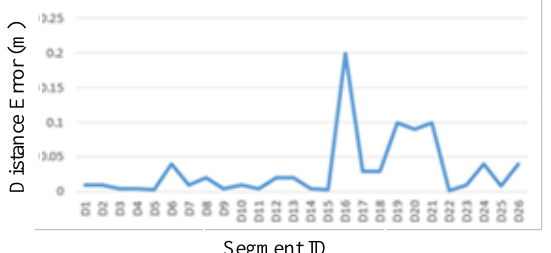
Figure 11. Error distance of the extracted segments and reference